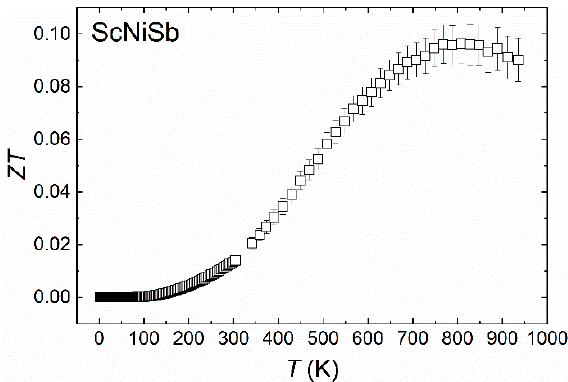
Figure 7. Thermoelectric figure of merit of ScNiSb as a function of temperature.